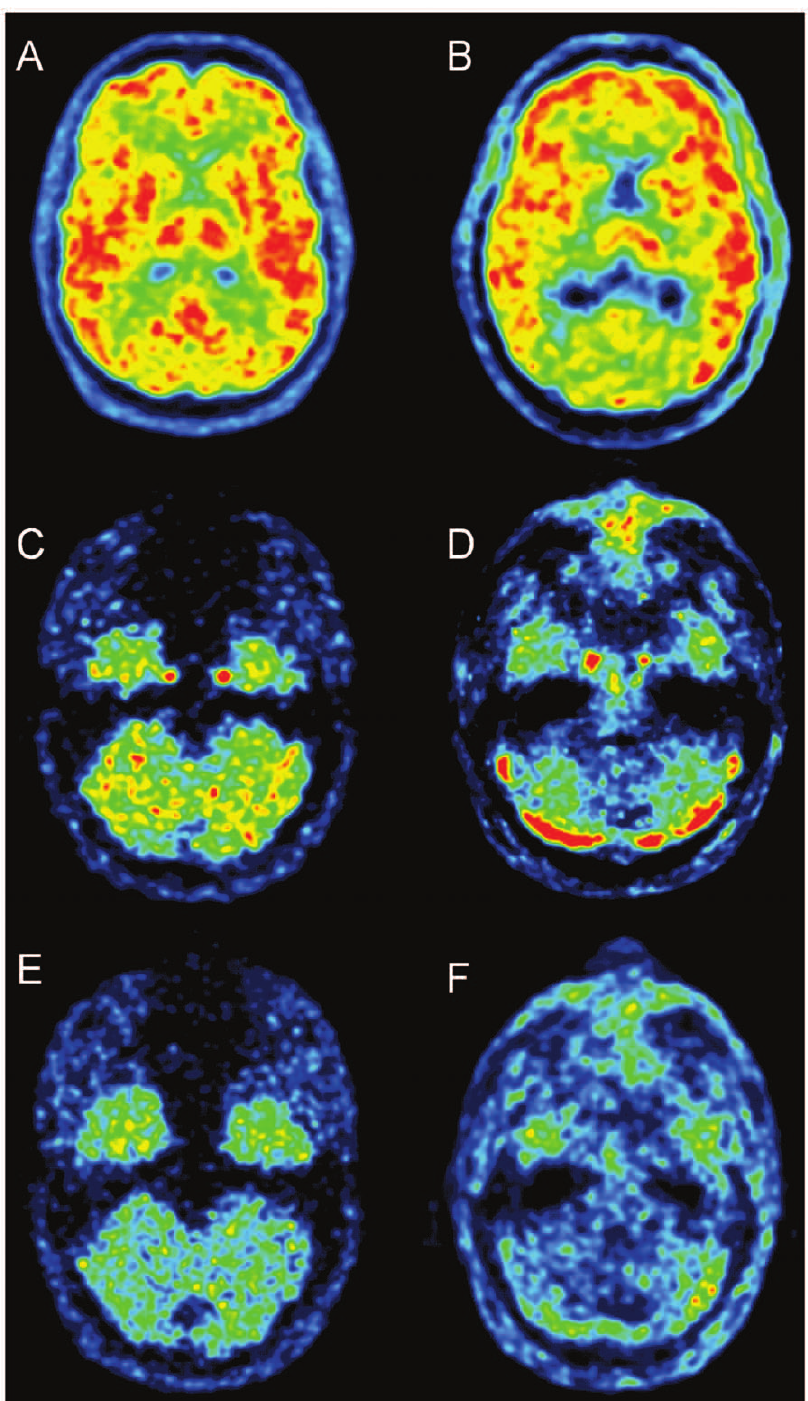
Figure 1. Transaxial slices from a [ 11 C]( R )-rolipram brain scan of a healthy volunteer and from a simulated study using a digital phantom. Upper row: [ 11 C]( R )-rolipram images across the thalamus summed over the whole duration of the scan from a phantom ( A ) and a healthy volunteer ( B ). The phantom images are realistic and quite similar to those from the real subjects. The external rim of activity surrounding the brain, in both the subject and the phantom, is scalp activity. Middle row: images summed over the first two minutes at the carotid level. The carotids are well visible near the temporal lobes for both the phantom ( C ) and the healthy volunteer ( D ). The regions of high activity visible in the lower part of the cerebellum of the subject ( D ) are the cerebellar venous sinuses (not simulated in the phantom studies). Bottom row: late images (three summed frames taken at about 1 hour after injection) from a phantom ( E ) and a subject ( F ). At late times the carotids are not well visible anymore and the spill-over effect from surrounding tissues becomes more important.